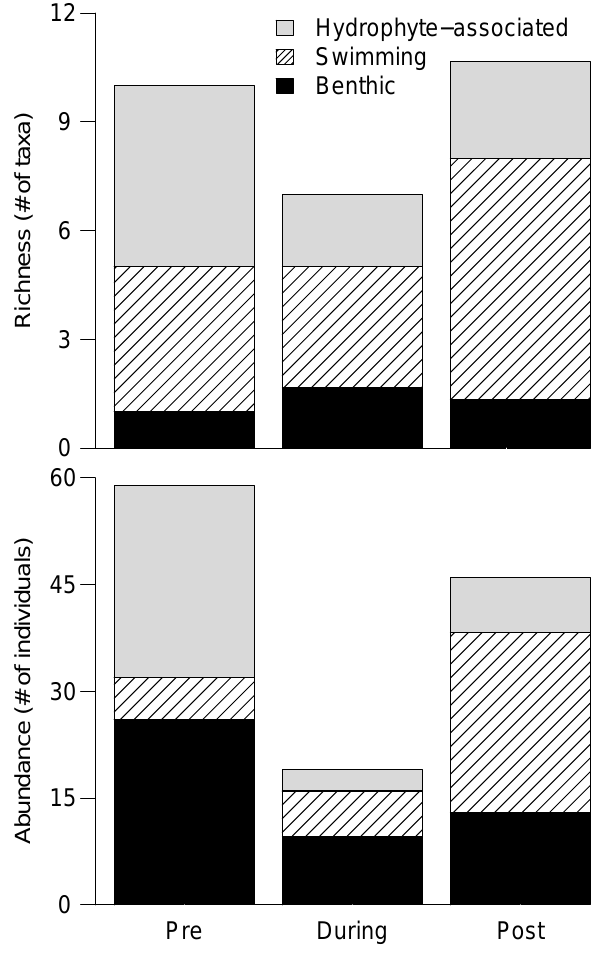
Fig. 5. Macroinvertebrate richness and abundance at the extreme dewatering site, grouped according to mobility/habit pre-, during-, and